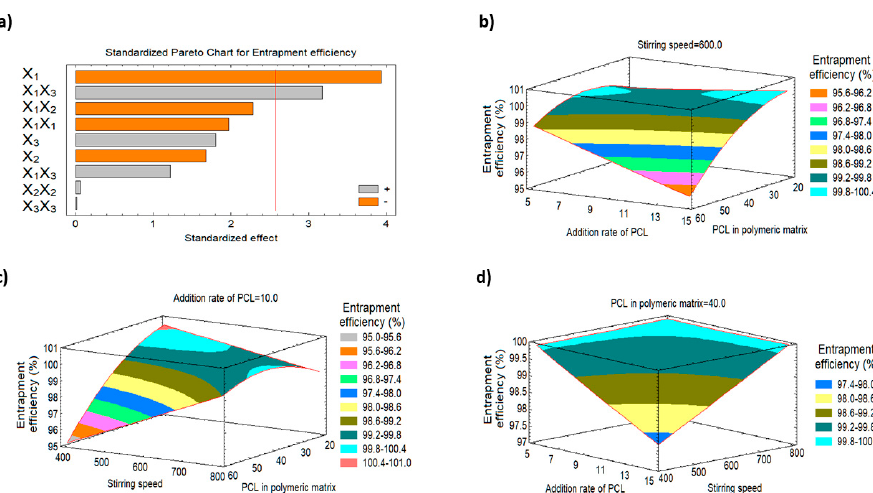
Figure 3. Pareto chart and the three-dimensional response surface plots representing the effect of changing the variables levels on the entrapment efficiency (Y3). ( A ) Standardized Pareto chart for entrapment efficiency. ( B ) The three-dimensional response surface plot of the effect of stirring speed on entrapment efficiency (Y3). ( C ) The three-dimensional response surface plot of the effect of addition rate of PCL on entrapment efficiency (Y3). ( D ) The three-dimensional response surface plot of the effect of PCL in polymeric matrix on entrapment efficiency (Y3).